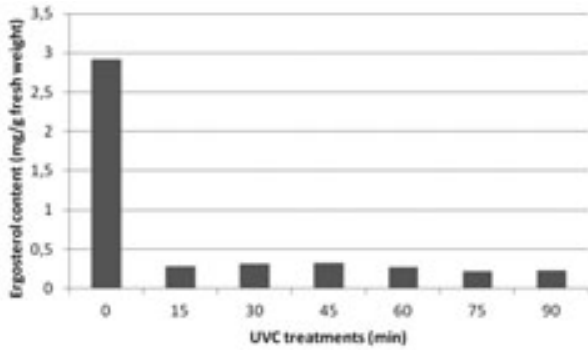
Fig. 4. Changes in ergosterol content in oyster mushrooms after 0 to 90 minutes of UVC